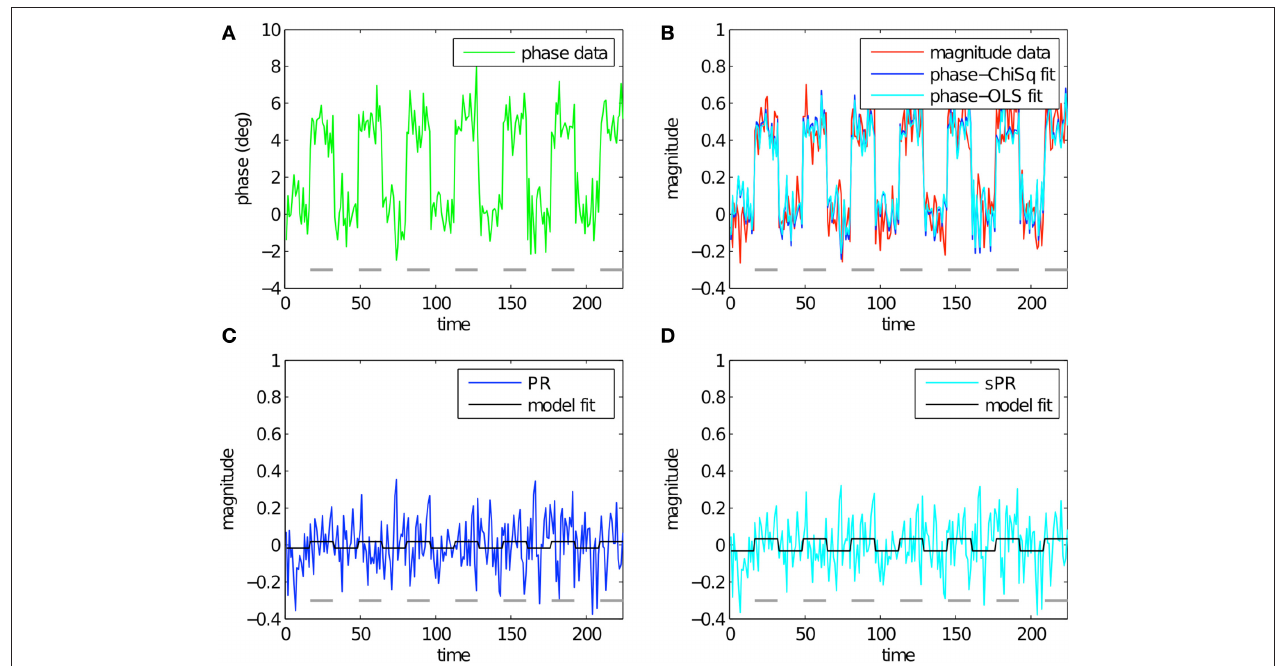
FIGURE 3 | Simulated large vein suppression in a voxel containing a large vein. In this regime, both phase, and magnitude fSNR are high. (A) Phase timecourse is plotted in green ( t = 5.16 ). Gray dashes indicate stimulus-on periods. (B) Magnitude timecourse is plotted in red ( t = 5.08 ). Linear fits of phase to magnitude using L ChiSq and L OLS are plotted in blue and cyan, respectively. Using L ChiSq yields larger absolute fits (e.g., larger b * 1 values). (C) PR large vein suppressed timecourse is plotted in blue ( t = 0.25 ). PR model fit timecourse is plotted in black. (D) sPR large vein suppressed timecourse is plotted in cyan ( t = 0.50 ). sPR model fit timecourse is plotted in black. In this regime, both PR and sPR show good suppression of BOLD activity. PR exhibits slightly stronger suppression than